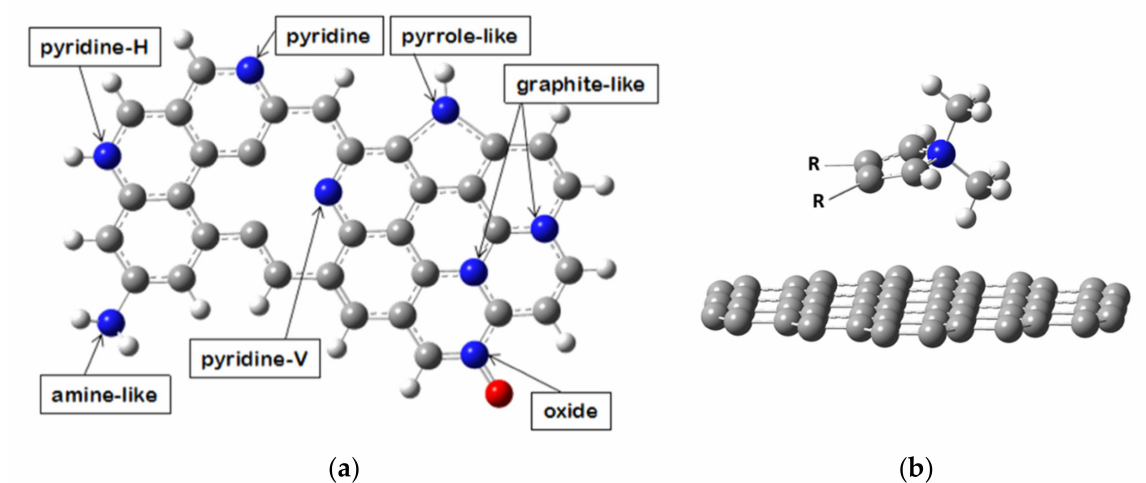
Figure 1. The schemes of the atomic structures for AMG and polydiallyldimethylammonium chloride–modified graphene oxide (GO-PDDA) ( a ) Nitrogen-containing functional group of amine-functionalized graphene synthesized using a chemical method. ( b ) Schematic of GO-PDDA nanosheets. (Blue is for nitrogen, gray is for carbon, red is for oxygen and the white is for